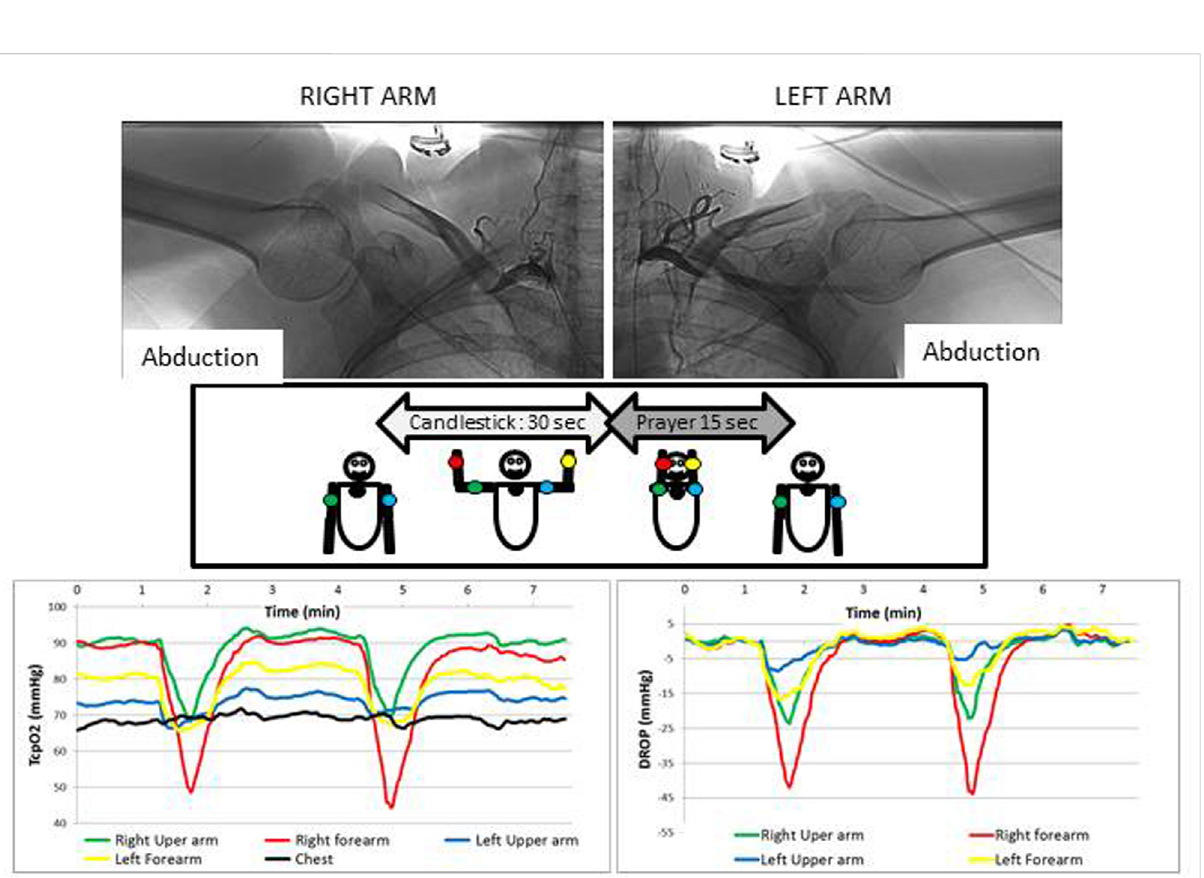
FIGURE 3 Typical example ofa patient complaining ofbilateral paraesthesia and pain during arm elevation. As shown, an arterial compression is observed during arteriography (upper panels), but whereas it is occlusive on the right side, on the left side the compression is not occlusive and a signi fi cant collateral circulation exists that likely explains why the decrease in DROP values is much more important on the right side than on the left. It is interestingtonotethatabsolutevaluesforTcpO2(leftpanel)areverydifferentatthedifferentprobepositionsandthatDROPvalues(lowerright panel) start to increase from the beginning of the prayer position, con fi rming that the decrease does not result solely from arm elevation. Also note that in this case the Ca-Pra procedure was performed twice, con fi rming the reliability of the results